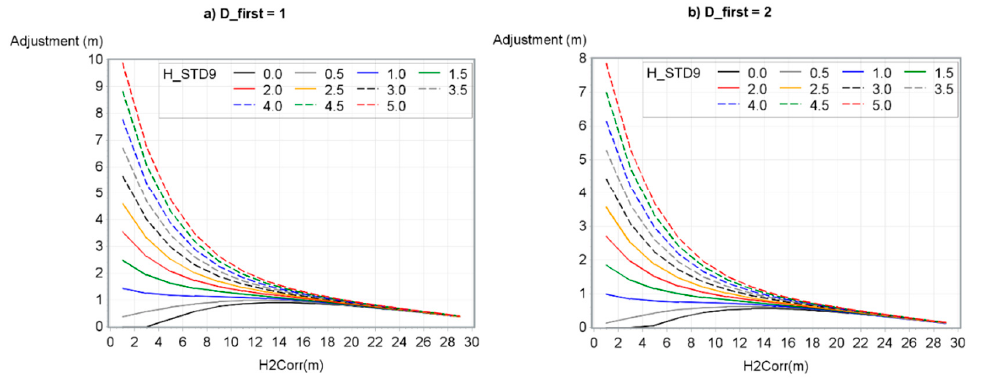
Table 5. Fixed coefficients of height adjustment model for CHM (Equations 3, 4 and 5).